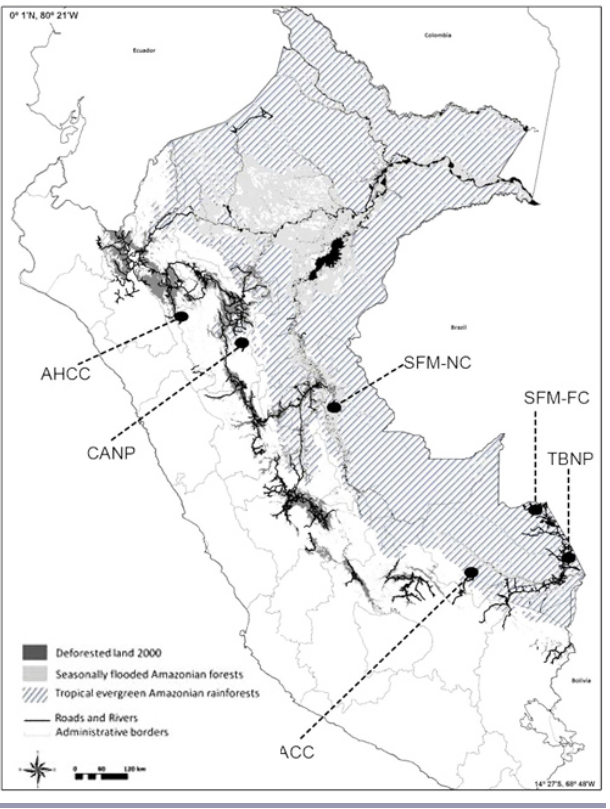
Fig. 1 . Location of the six Peruvian REDD+ pilot